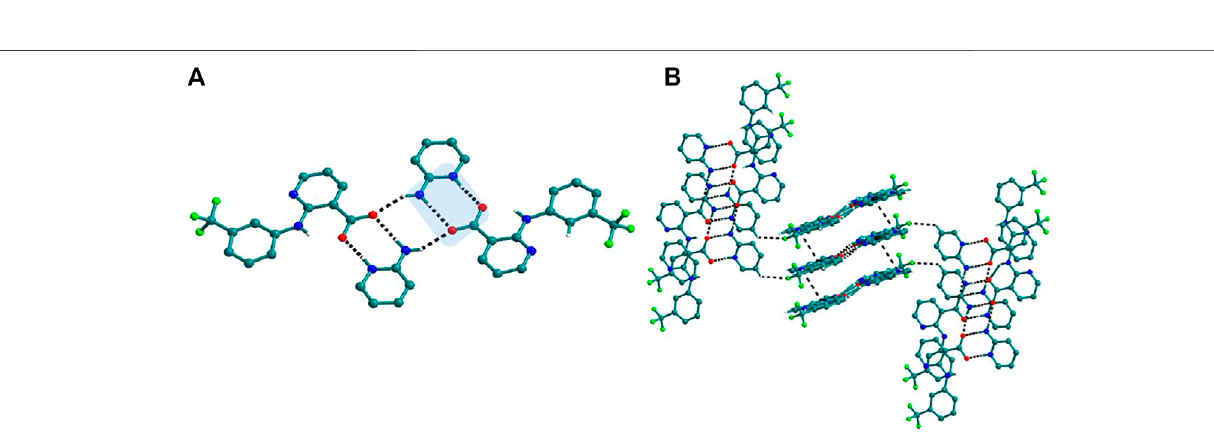
Frontiers in Chemistry |